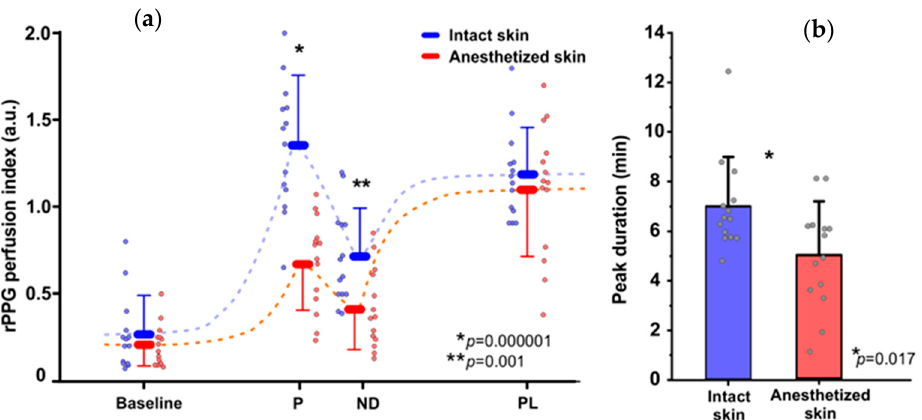
Figure 5. ( a )-Topical skin heating induced vasomotor response in intact and anesthetized skin, group (n = 14) mean data ± S.E.M., subjects individual measurements marked with small circles; ( b )-Topical skin heating induced vasomotor response peak duration, group (n = 14) mean data ± S.E.M. from intact and EMLA anesthetized skin regions, subjects individual measurements marked with black small circles. Statistically significant difference denoted by asterisks.